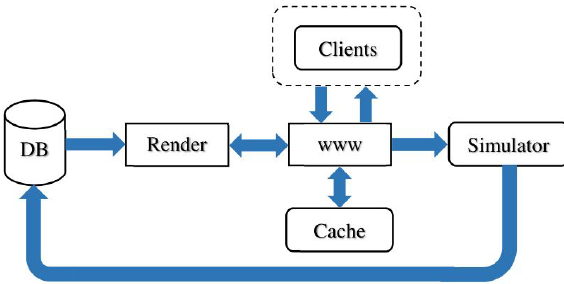
Figure 9. Tile map server architecture: tiles are requested from the web page server that either return a cached image or ask the rendering engine to compose it from a data base of geographical